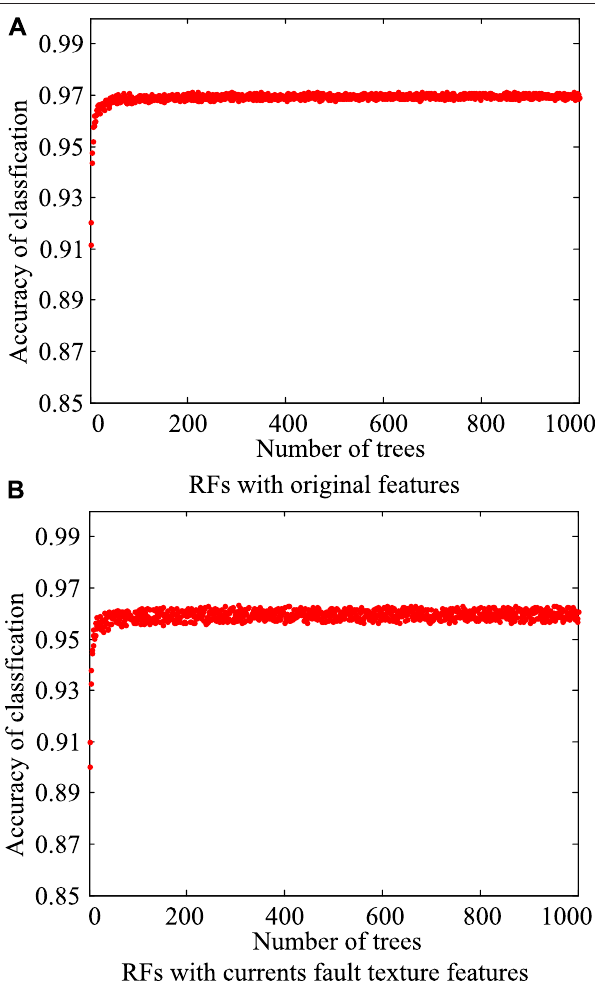
FIGURE 12 | In fl uence of decision tree on performance of